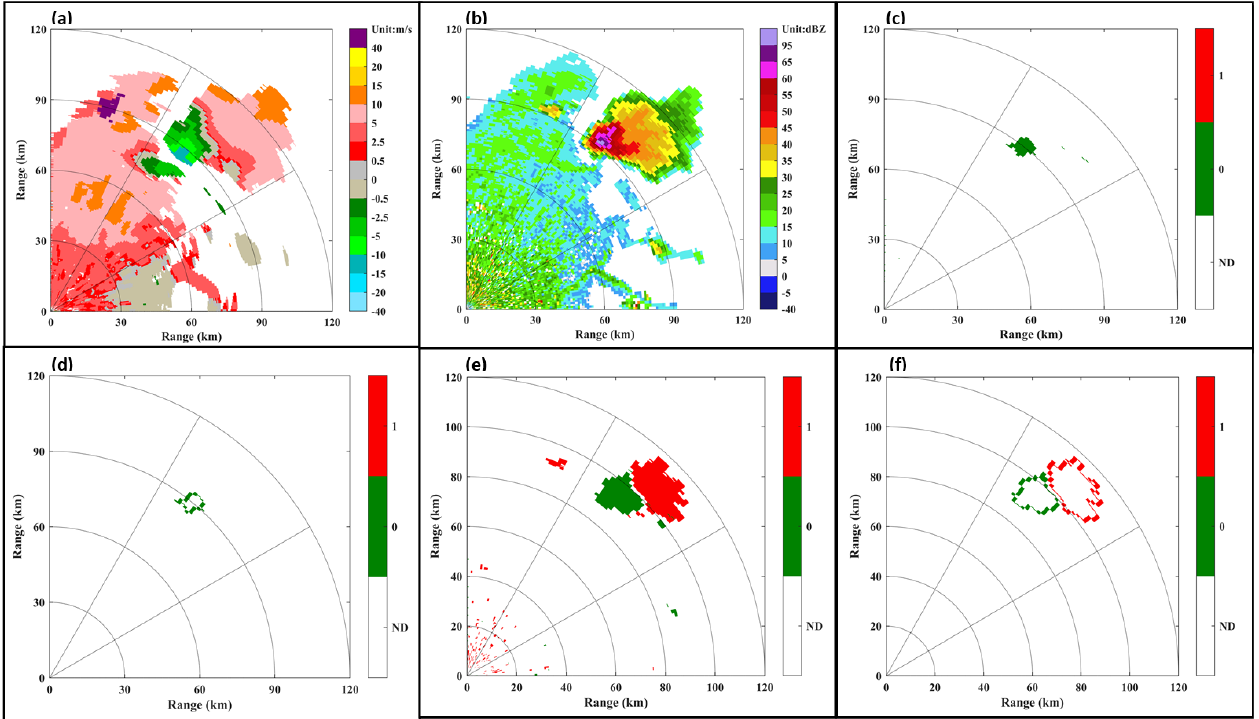
Figure 18 Figure 18. Radar echoes at an elevation angle of 0.5 ◦ from Jinan, Shandong, on 27 June 2009, 16:31. ( a ) The PPI of radial velocity, ( b ) the PPI of reflectivity, ( c ) radial velocity binarization using the Du’s algorithm, ( d ) Eight-Neighborhood method edge detection using the Du’s algorithm, ( f ) radial velocity binarization using the algorithm in this paper, and ( e ) Eight-Neighborhood method edge detection using the algorithm in this paper. In ( c – f ), the red outline represents the positive velocity area, and green outline represents the negative velocity